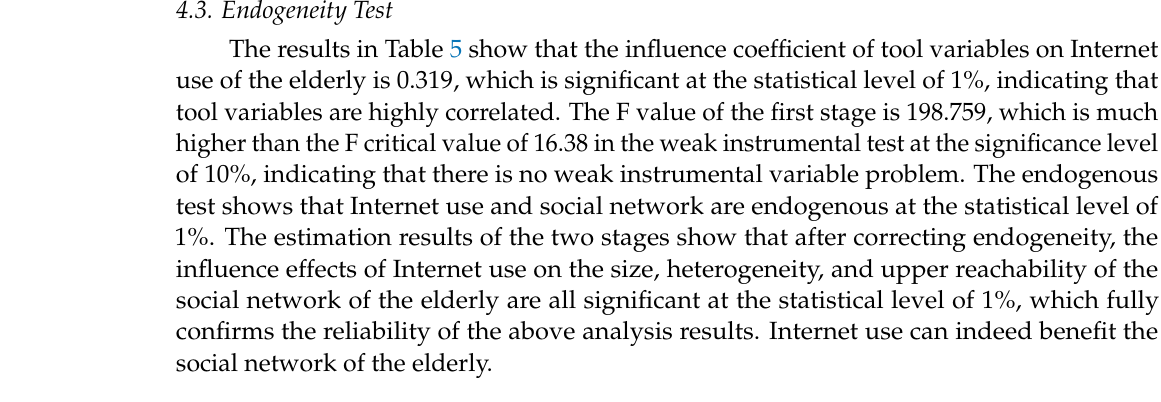
Table 5. Regression results of the instrumental